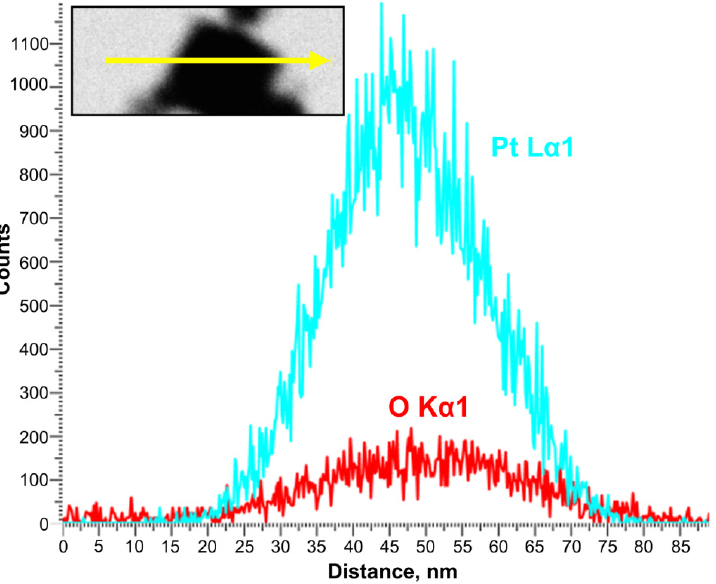
Figure 7. EDX profile of Pt nanoparticle synthesized by spark discharge under air. The inset shows the TEM image of the measured platinum nanoparticle and the corresponding scan line.